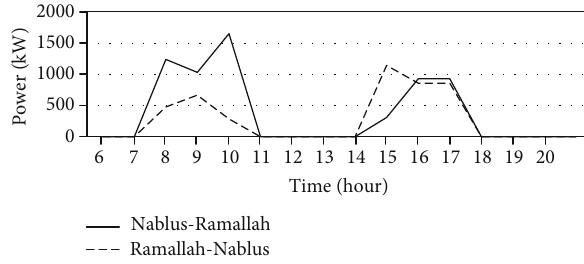
Figure 10: Daily hourly load demand of the adapted run round trip for the third